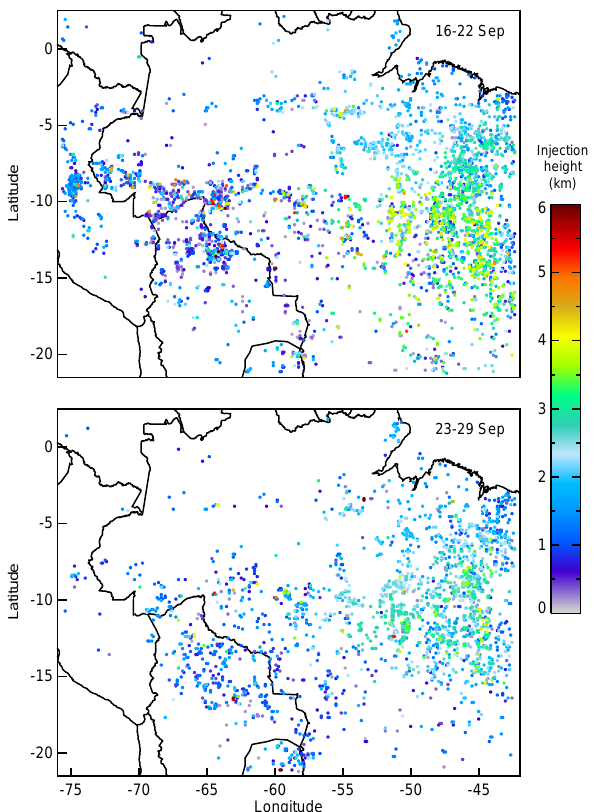
Figure 12. Hotspots during 16–22 September (top) and 23– 29 September (bottom), as reported in the GFAS inventory. Each hotspot is coloured according to the corresponding injection height computed by the plume rise model embedded in